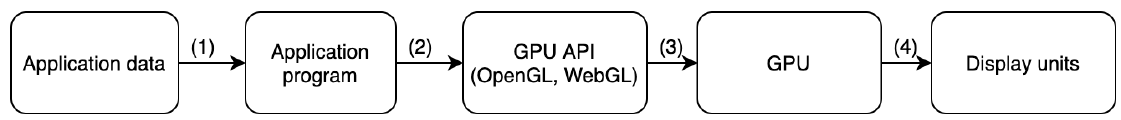
Figure 2. Information visualization on computer screen via computer graphics technique.